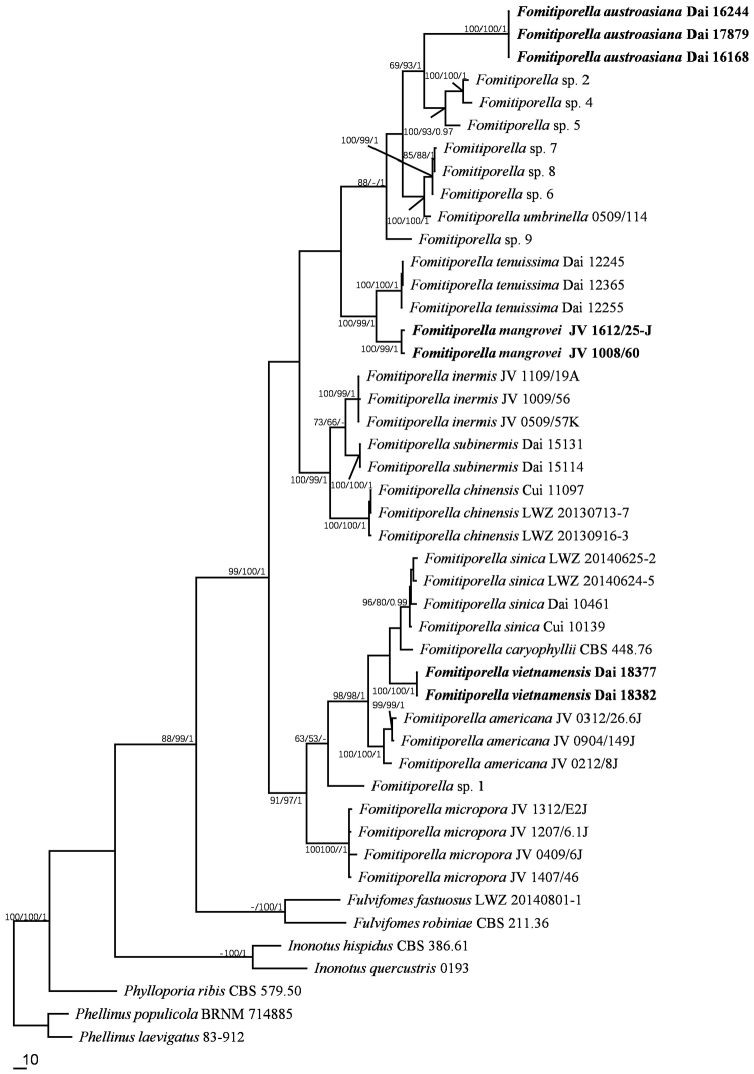
Phylogeny of Fomitiporella inferred from the ITS dataset. The topology is that of the MP analysis, and statistical values (ML/MP/BI) are indicated for each node that simultaneously received BS from ML and MP not below 50 %, and BPP from BI not below 0.9. Phellinus
laevigatus and P.
populicola are used to root the tree. Branch lengths reflect the number of steps as indicated by the scale.